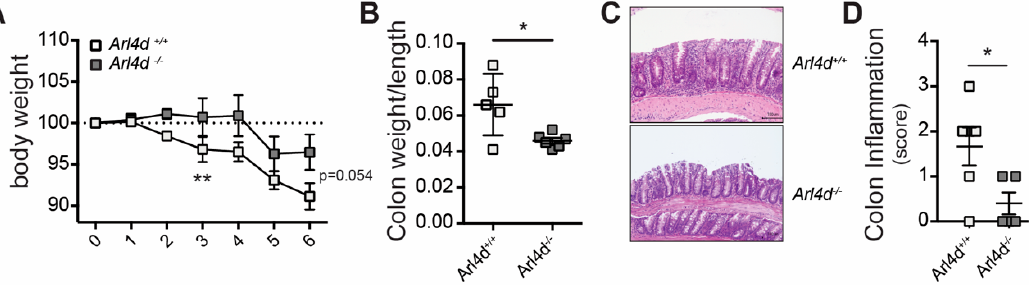
Figure 2. Arl4d deficiency does not aggravate CD4-mediated transfer colitis in Rag2 − / − mice. Rag2 − / − mice received 5 × 10 5 sex-matched sorted splenic CD4 pos CD25 neg CD62L high T cells from Arl4d +/+ or Arl4d − / − mice. ( A ) Weight loss of the mice over time (as % of starting weight) in weeks. ( B ) Colon weight-to-length ratio at 7 weeks after T-cell transfer. ( C ) Representative H&E staining and ( D ) histological score of inflammation of the colons of mice transferred with either Arl4d +/+ or Arl4d − / − CD4 T cells 7 weeks after T-cell transfer. Representative data of two experiments ( n = 4–6/group). Statistical significance was calculated using ANOVA, * p ≤ 0.05, ** p ≤